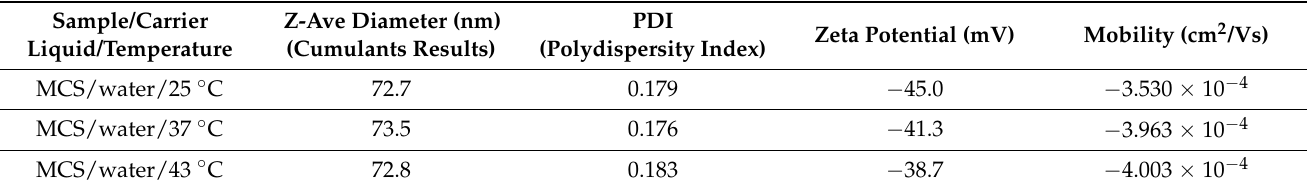
Figure 8. The intensity distribution of particle size contained in aqueous MCS. Table 2. Structural characterization parameters of MCS based on MIONPs dispersed in distilled water recorded at different temperatures.